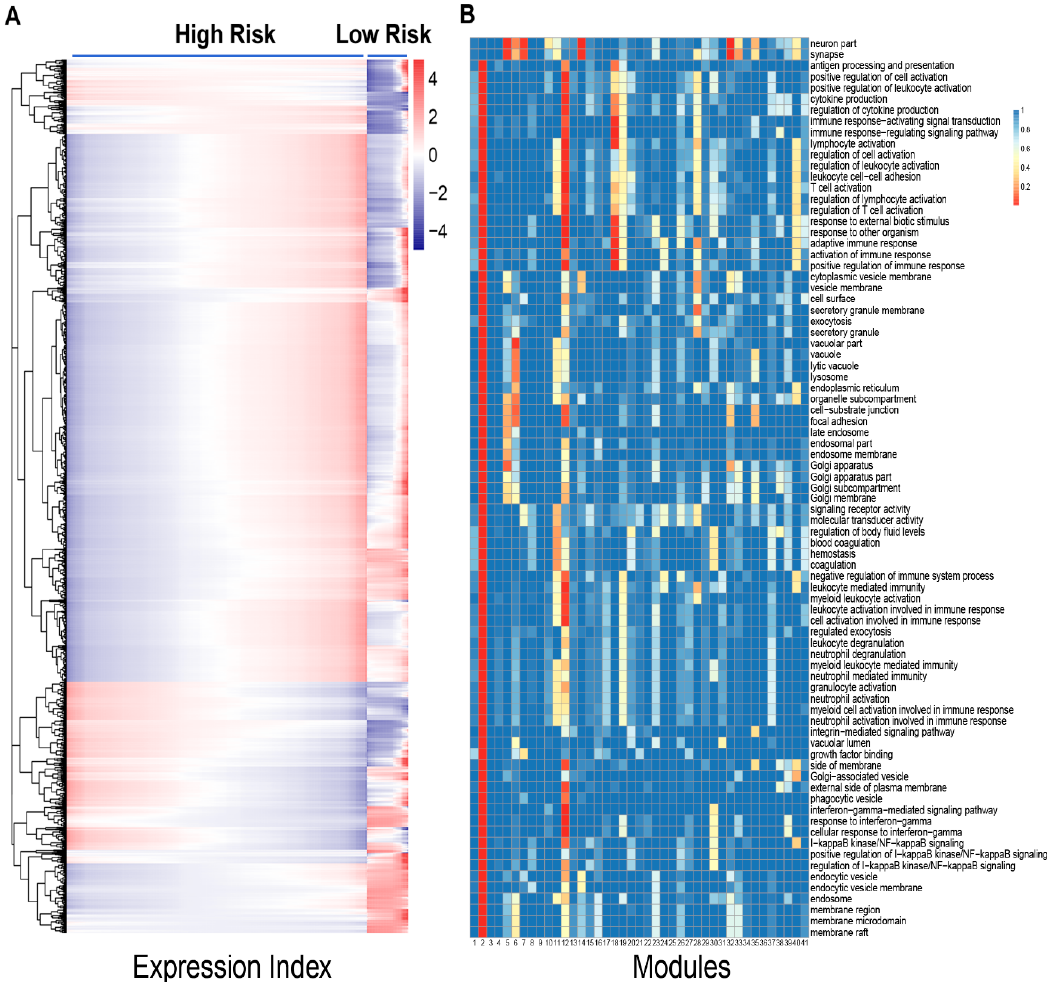
Figure 2. Functional clustering of 3439 genes into 41 distinct modules across 247 samples from high- (217) and low-risk groups (30) ( A ). Genes within each of the 41 modules are annotated for their biological functions ( B ).